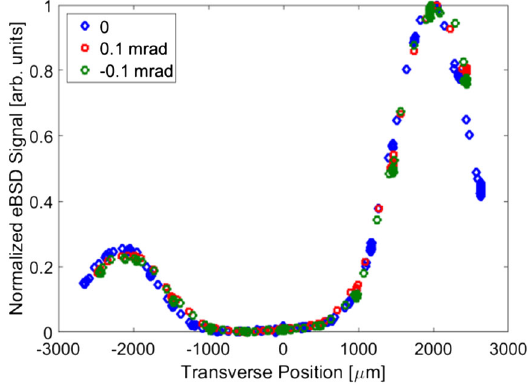
FIG. 9. Angle alignment with the